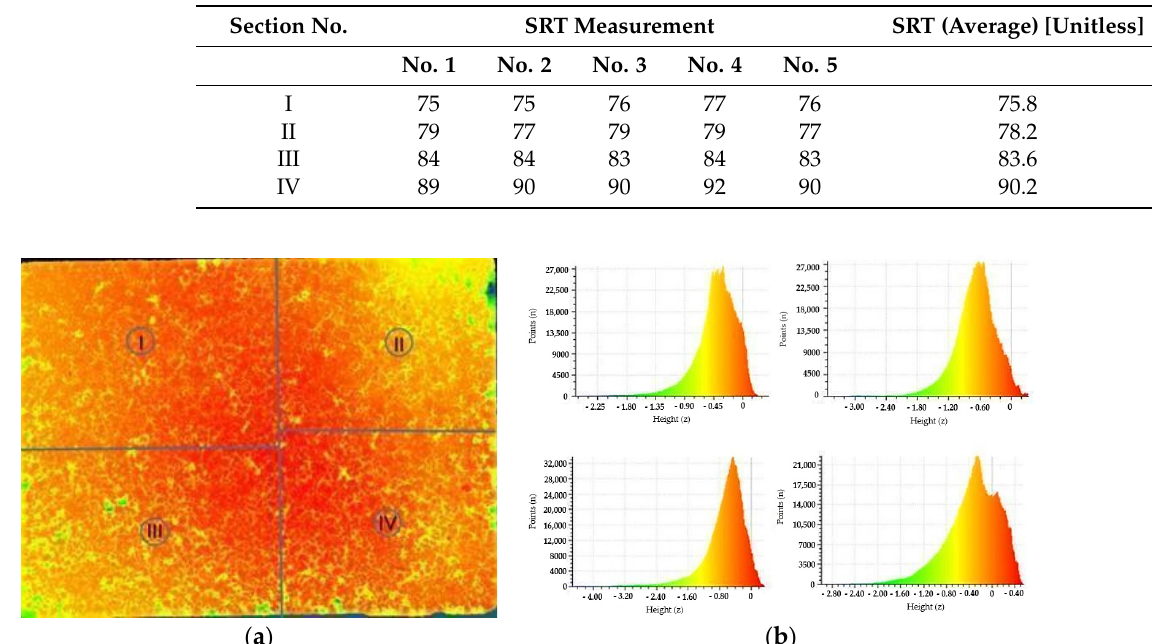
Figure 4. Height maps of analyzed slab sub-sections ( a ) and corresponding histograms ( b ) generated from the Cloud Compare software.